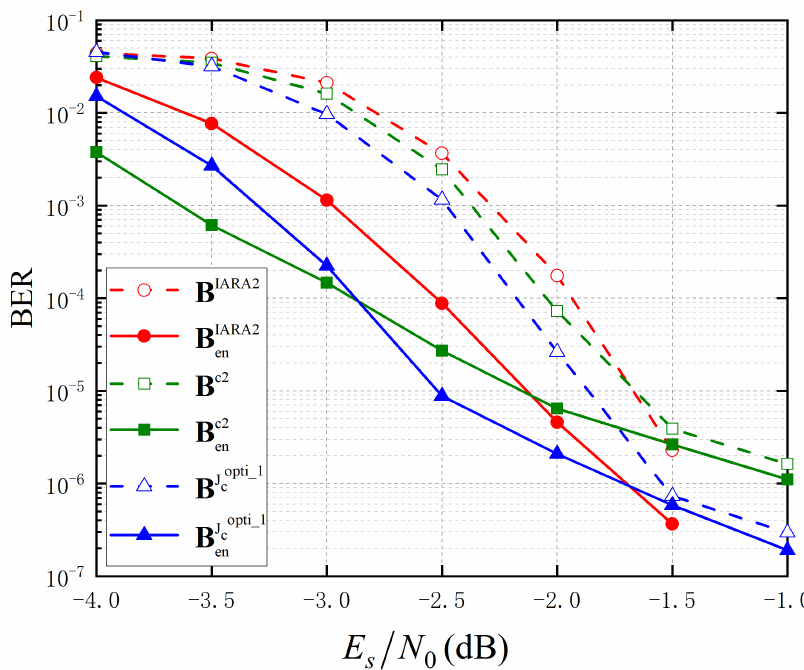
Figure 3. Simulated BER results of the enhanced and the benchmark codes at p =